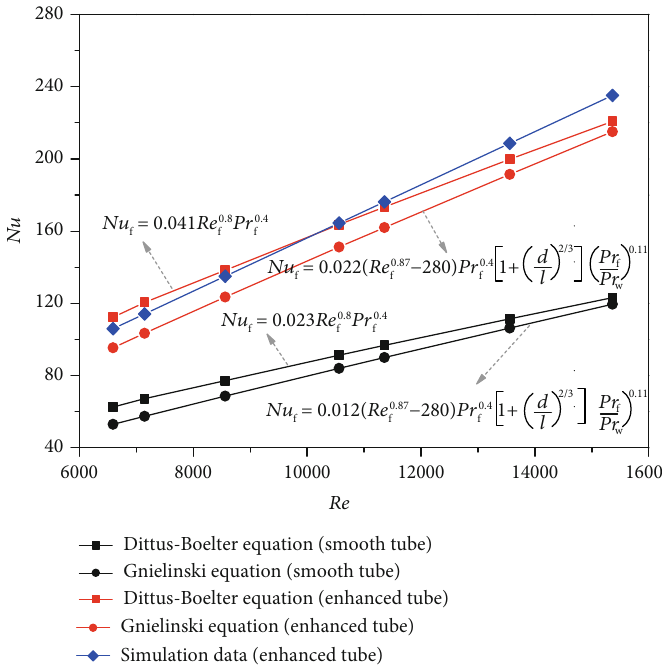
Figure 9: Comparison of Nu between the simulation data and empirical data.